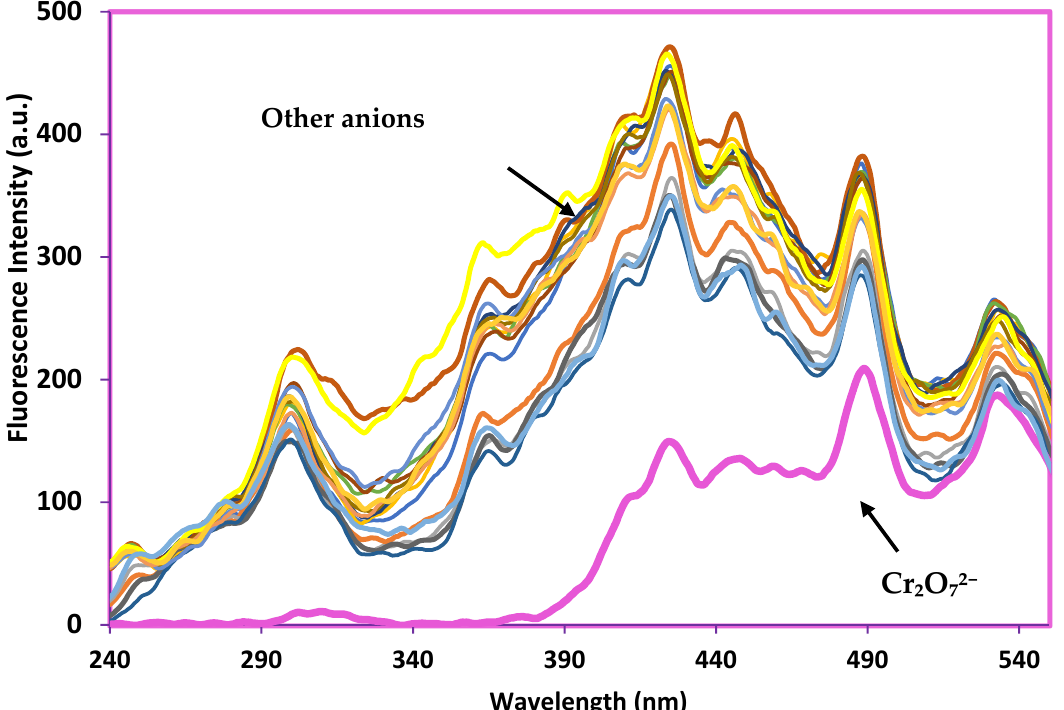
Figure 11. Fluorescence spectra of the aqueous suspended SBA-Pr-Is-TAP (0.2 g L − 1 ) in the presence of different anions (100 µ L of M n − (1 × 10 − 4 M)), including I − , CN − , Cl − , F − , Br − , CO 32 − , SO 42 − , NO 2 − , NO 3 − , HCO 3 − , H 2 PO 4 − , CH 3 COO − , SCN − , S 2 O 32 − , OH − , and Cr 2 O 72 − ( λ ex = 220 nm, λ em = 420 nm).